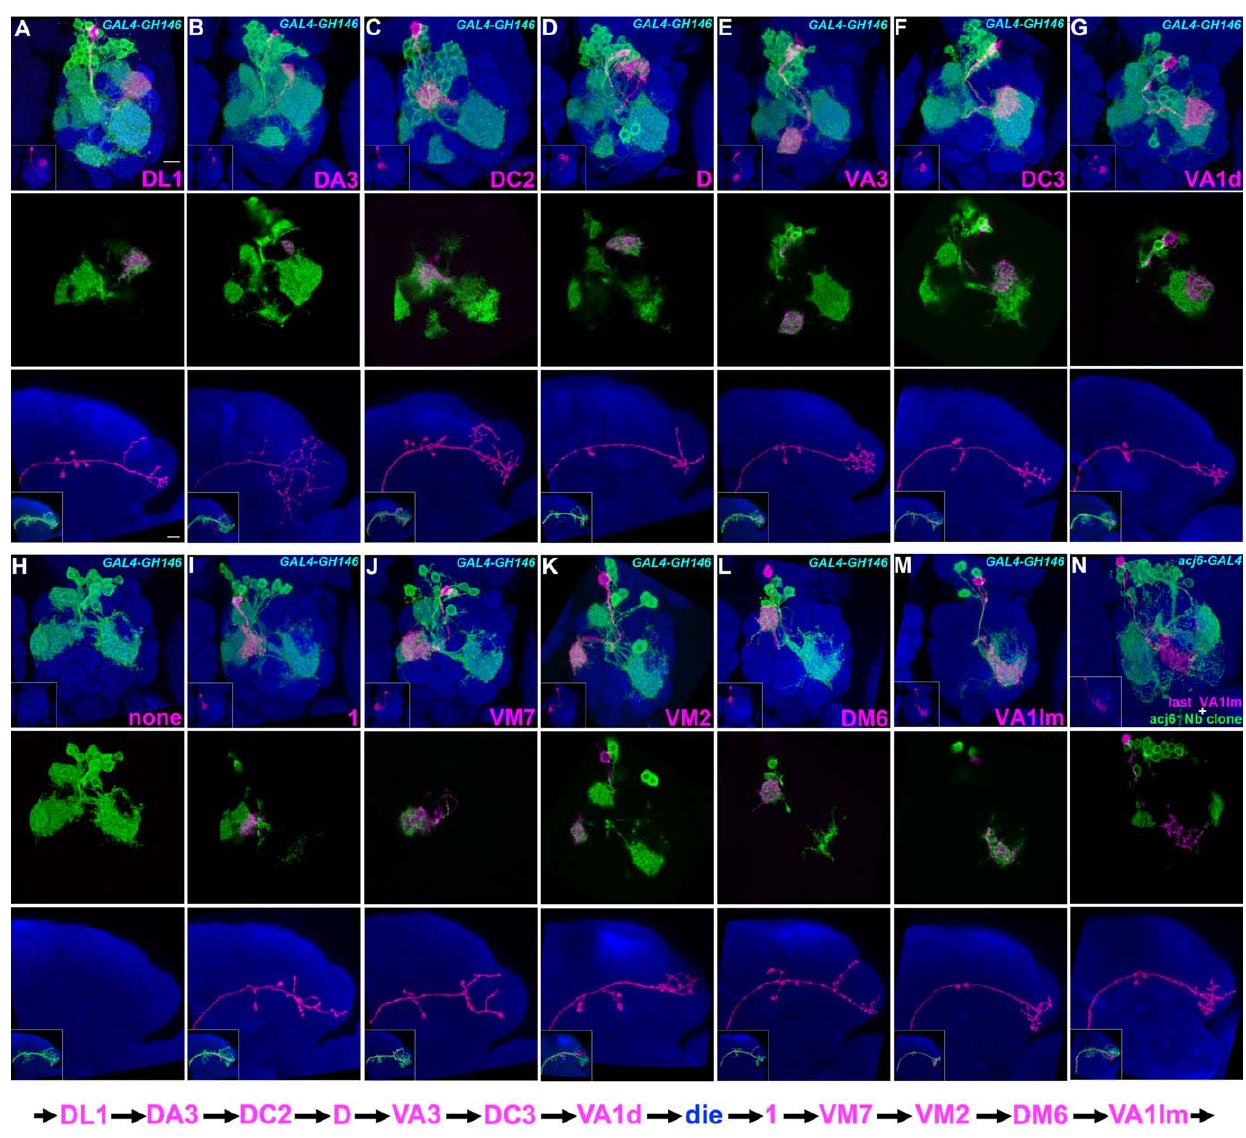
Figure 2. Twelve types of early-larval-derived GH146-positive uniglomerular adPNs. Twin-spot MARCM clones of adPNs labeled with GAL4-GH146 (A-M) or acj6-GAL4 (N). Top panels: composite confocal images of sister clones in the AL; middle panels: single focal sections of the AL covering the glomerular targets of GMC progeny (magenta); bottom panels: axon projections of GMC progeny (magenta); islets in bottom panels: axon projections of both GMC progeny (magenta) and its paired NB clone (green). Note each adPN type (magenta) consistently pairs with adPN NB clones (green) of specific compositions. Analysis of NB clones revealed the 12 types of GH146-positive adPNs are made in an invariant sequence from (A) to (M). And all the lone, unpaired NB clones (H), whose preceding GMC progeny probably die prematurely, were induced in the interval between VA1d and 1 adPNs. The sequence of early-larval adPN neurogenesis is summarized in the bottom. In addition, there are multiple neurons per type, as evidenced in middle panels that the glomerular target of GMC progeny can be co-labeled by its accompanying NB clone. For the lineage after VA1lm PNs, one can visualize GH146-negative adPNs with acj6-GAL4 as revealed in (N) where the last VA1lm adPN pairs with a 32-neuron-containing NB